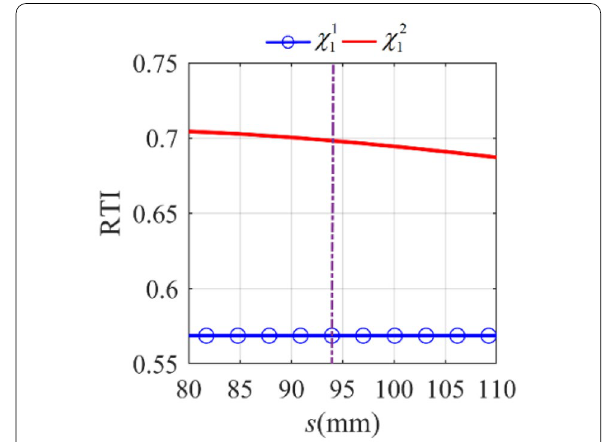
Figure 14 RTI near the mixed